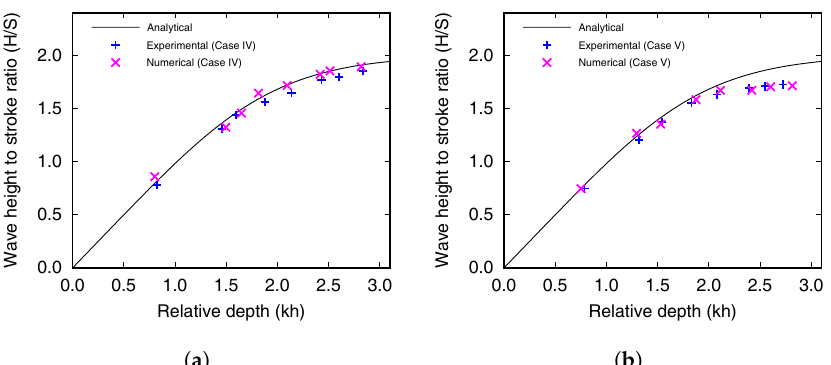
Figure 14. Curves showing a comparison of the wave height to stroke ratio obtained using the wavemaker theory, experiment, and via numerical simulations. ( a ) Cases IV-1 to IV-8 and ( b ) Cases V-1 to V-8.